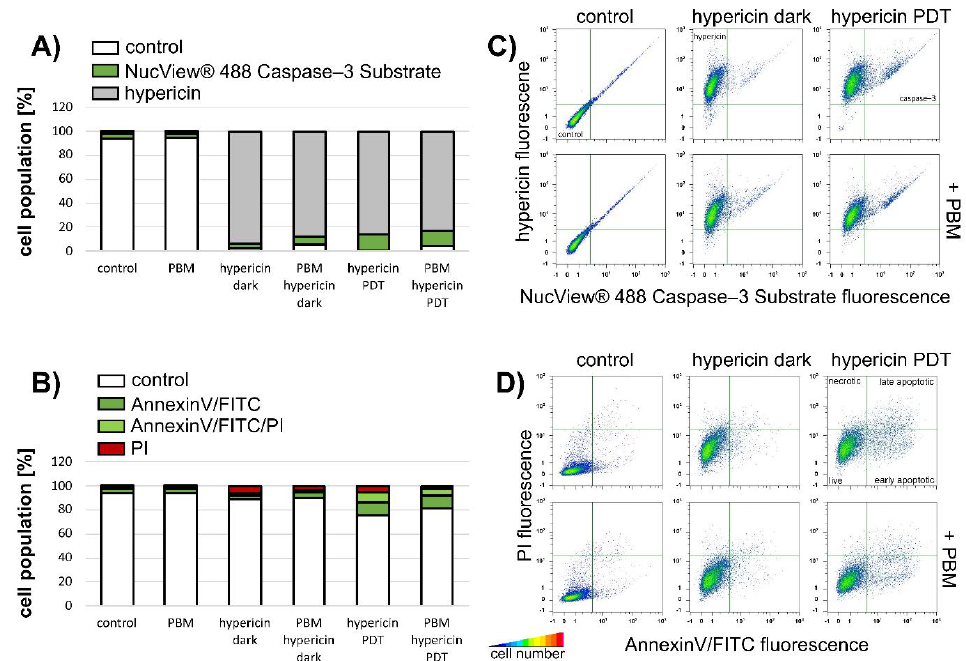
Figure 8. Flow cytometric analysis of ( A ) caspase-3 production (stained with NucView ® 488 caspase-3 substrate (green histograms)) and ( B ) apoptosis/necrosis (stained with AnnexinV/FITC (green histograms) and PI (red histograms)) in U87 MG cells without treatment and treated with PBM, 200 nM hypericin in the dark, after PBM and PDT, as shown in the histograms. Detection was performed 5 h after PDT. White histograms show cells without staining and gray histograms show cells labeled with hypericin. ( C ) Correlation plots of the fluorescence intensities of hypericin and NucView ® 488 caspase-3 substrate in the detected cells. ( D ) Correlation plots for the intensity of fluorescence of PI and AnnexinV/FITC in the detected cells. Cell number is color-coded (blue — minima, red — maxima).